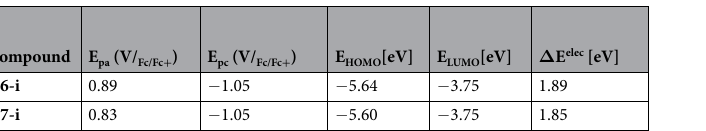
Table 2. Electrochemical data recorded at a concentration of 0.5 mM in 0.10 M Bu 4 NPF 6 /CH 2 Cl 2 , 100 mV.s − 1 , Pt working electrode, Reference: Fc/Fc + . E